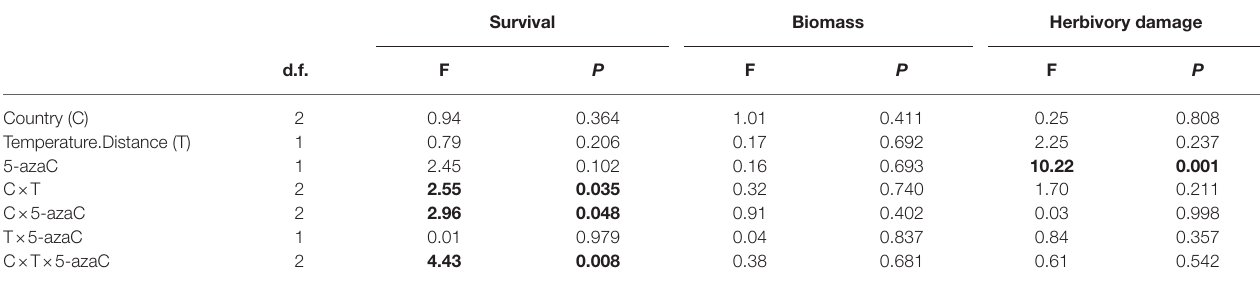
TABLE 3 | Test of role of DNA methylation in adaptation to warm and/or cold conditions (Hypothesis 3).